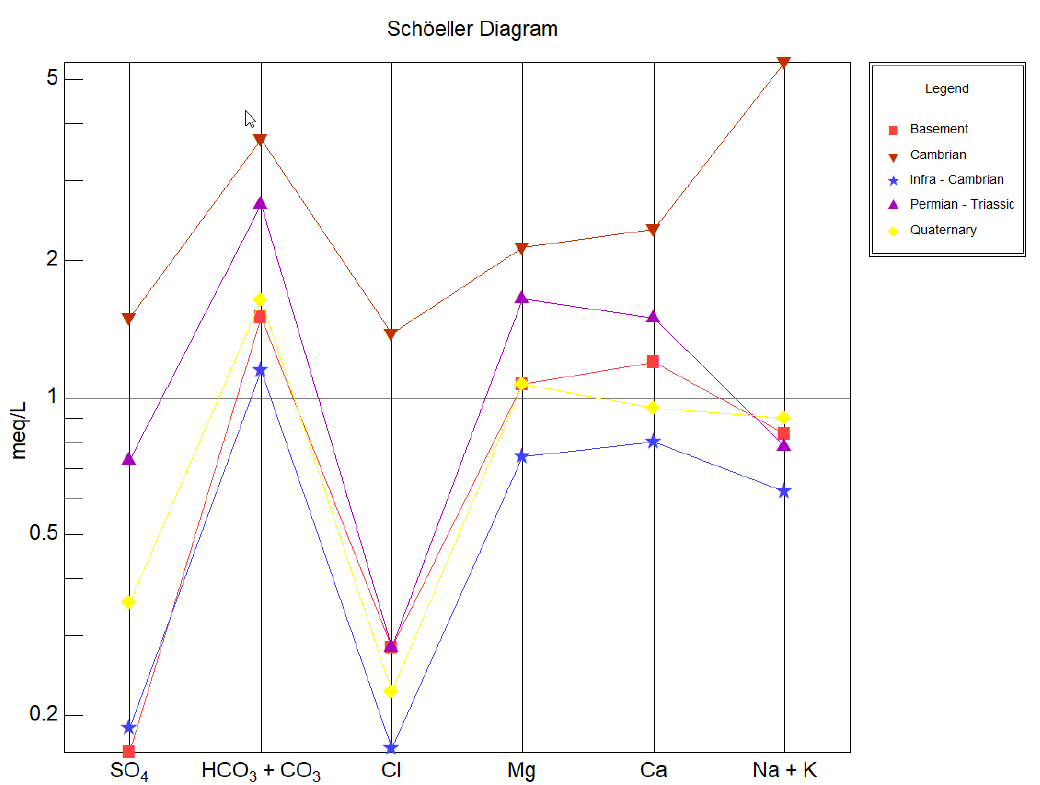
Figure 4. Schöeller diagram distinguishing similar patterns in the anion and cation ratios. Table 2. Pearson correlation